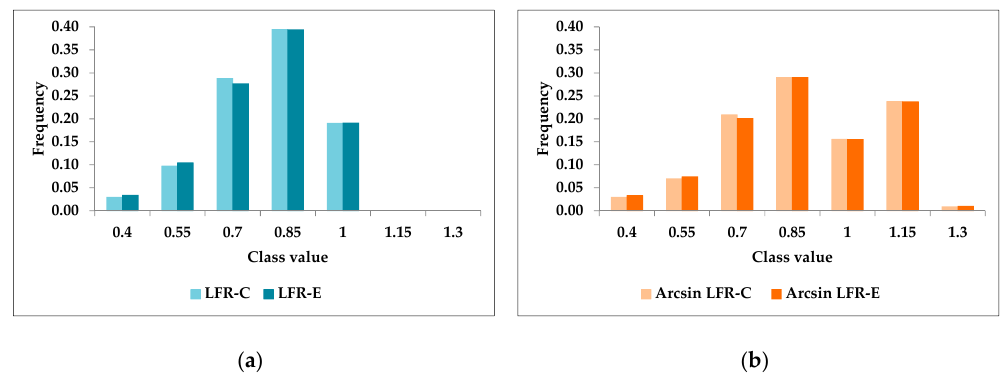
Figure 1. Class distribution of lifetime fertility rate (LFR) obtained in the full dataset ( n = 3033) combining actual and predicted foals after the 6th breeding season; In ( a ) distribution of linear LFR obtained by predicting incomplete reproductive career with coefficients (LFR-C) or equations (LFR-E); in ( b ) normal distribution of arcsine transformed LFR obtained by predicting LFR with coefficients (Arcsine LFR-C) or equations (Arcsine LFR-E).